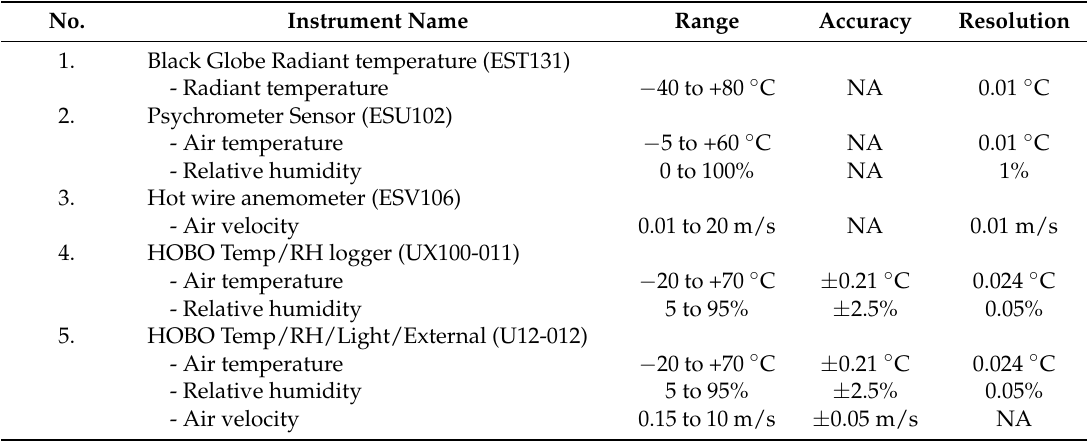
Table 3. The specification of instruments used in the